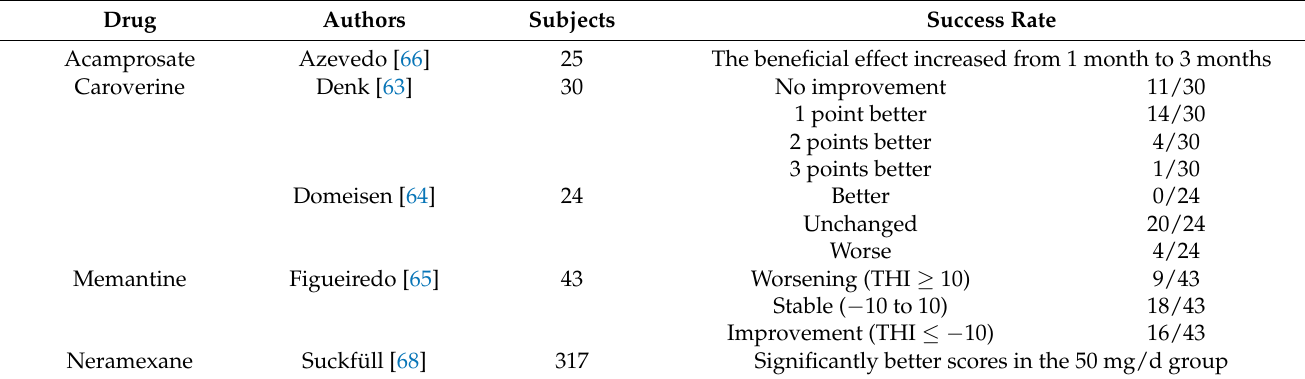
Table 9. Summary of studies that used NMDA antagonists to treat